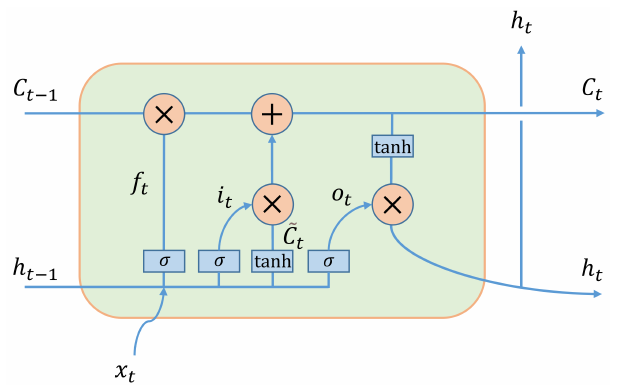
Figure 4. Sketch map of the LSTM unit.